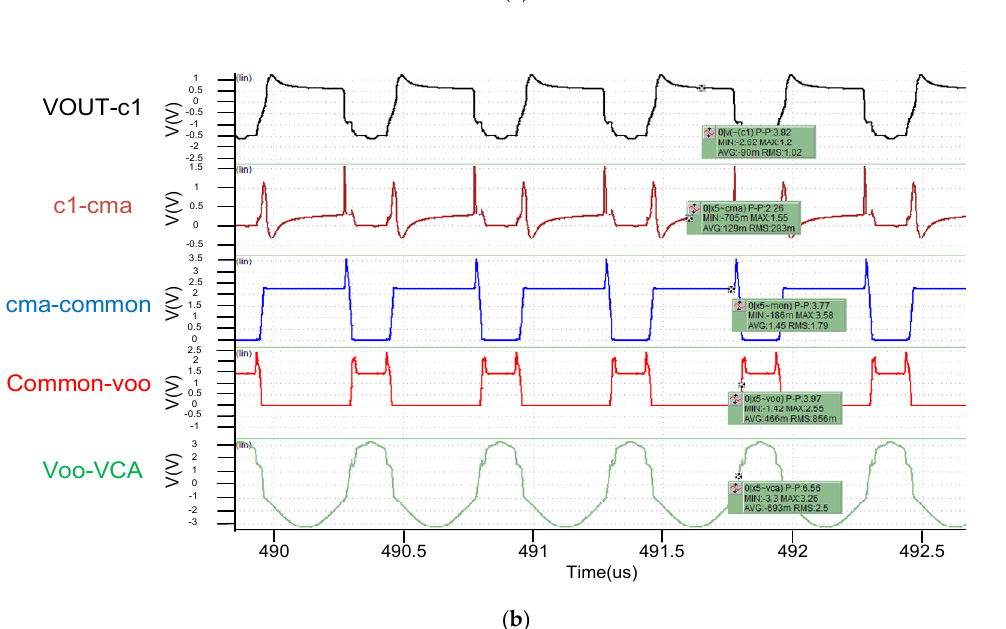
Figure 16. ( a ) Transient simulaiton of proposed rectifier; ( b ) Transient simulation for breakdown check.